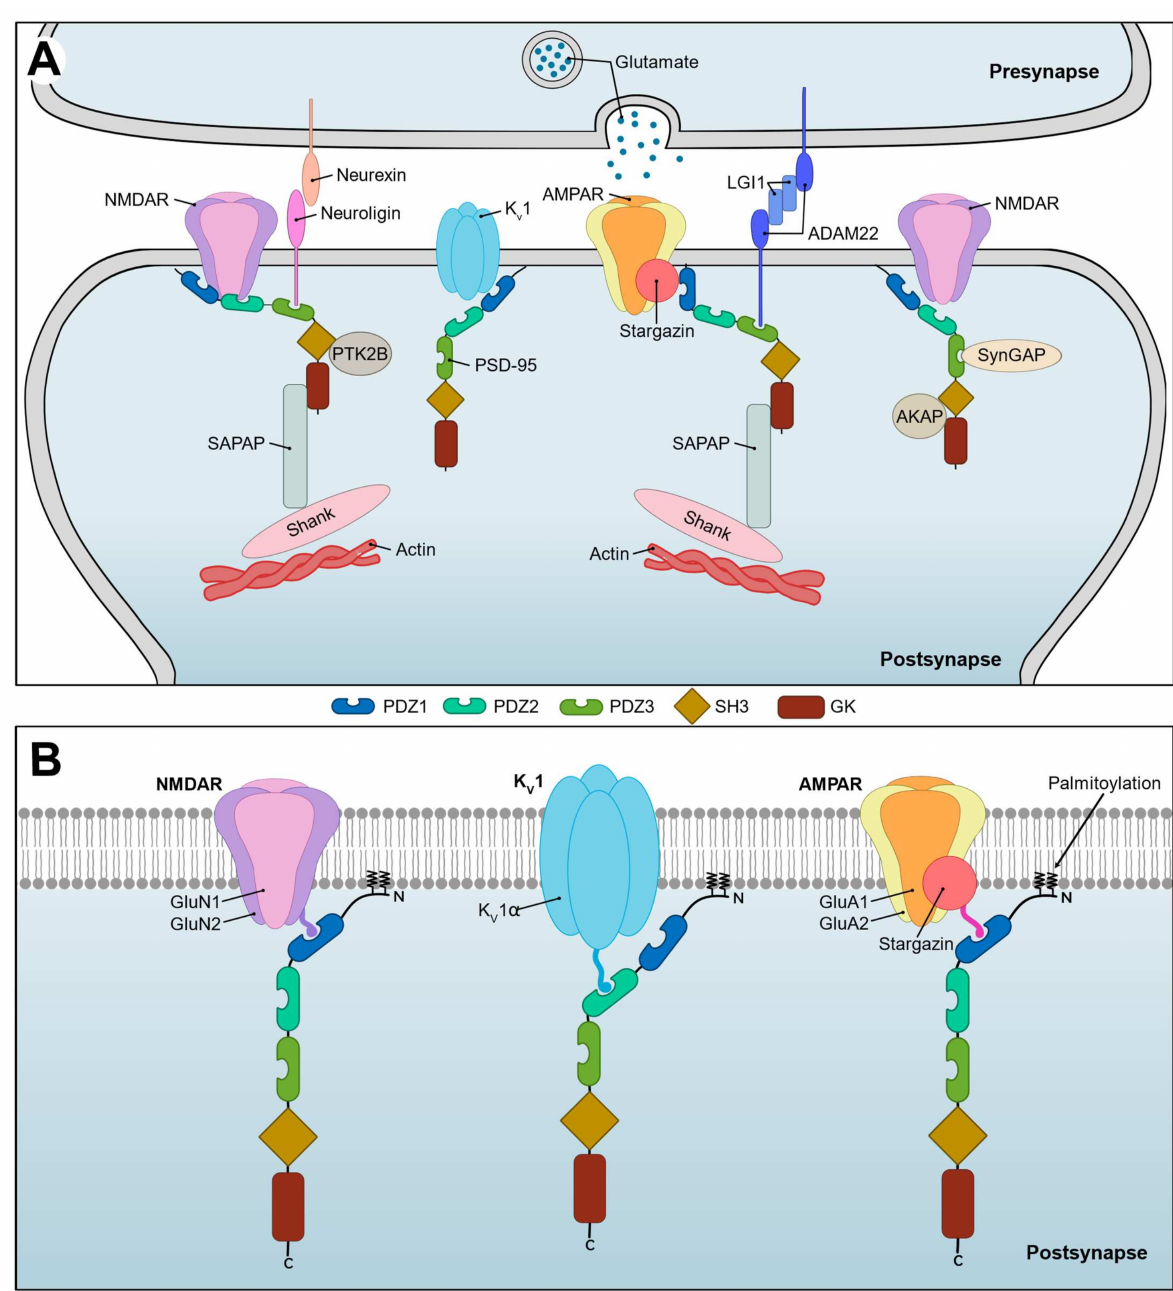
Figure 1. Simplified schematic overview of the major PSD-95 interactions in the postsynaptic density. ( A ) PSD-95 anchors K v 1 channels, NMDA receptors, and AMPA receptors (through stargazin) to the postsynaptic membrane as they bind the first two PSD-95/Discs large/Zonula occludens 1 (PDZ) domains of PSD-95, whereas neuroligin and ADAM22 bind the third PDZ domain. Amongst others, PSD-95 also binds PTK2B, which is recruited to the NMDAR-PSD-95-complex through binding to PSD- 95 SRC homology 3 (SH3) domain, AKAP, which links the NMDAR–PSD-95-complex with signaling enzymes (not shown), and SynGAP, which binds all three PSD-95 PDZ domains. Furthermore, SAPAP binds PSD-95 guanylate kinase-like (GK) domain and actin-binding Shank, forming a scaffolding protein complex, which anchors the actin cytoskeleton to the postsynaptic membrane. Transsynaptic interactions include the neuroligin–neurexin interaction as well as the ADAM22–LGI1–complex. The location of the latter is based on one of the models proposed by Fukata et al. [3]. ( B ) Representative diagram of the structure of NMDAR, AMPAR, and K v 1 as well as their interaction with PSD-95,